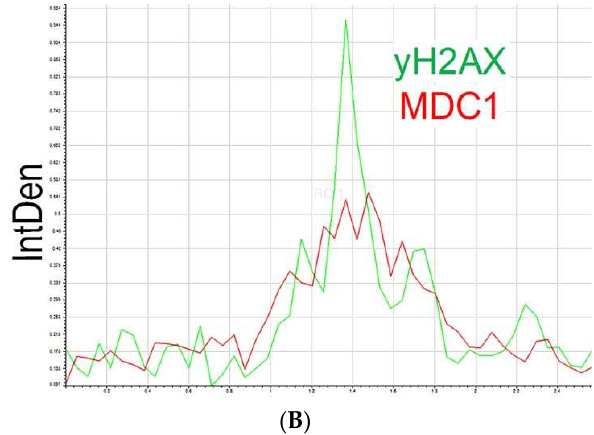
Figure 2. ( A ) Double immunostaining of γH2AX Ser139 /MDC1 (arrowheads) in pronuclei during the G1- and G2-phases of one-cell stage embryos. The DAPI staining (blue) shows pronuclei. The Z-projections of confocal section across whole nuclei are shown. Scale bar = 10µm. ( B ) Graph represents the fluorescence image profile and co-localization analyses for γH2AXSer139 /MDC1 in the immunopositive foci. The X-axis represents the length of analyzed line on the picture “Control G2” (red bar).